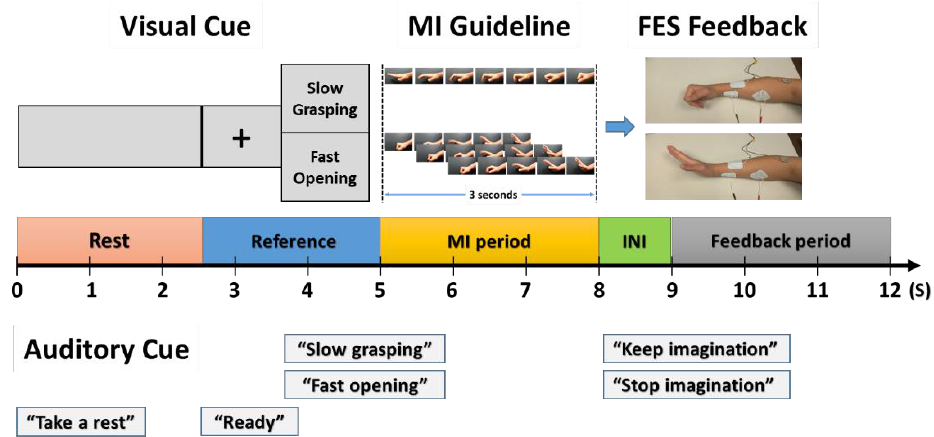
Figure 1. Schematic illustration of the experiment procedure. Text in the blue box indicates the auditory cue that played at the beginning of each period, and INI is an abbreviation of the Functional Electrical Stimulation (FES) initiation period. MI: Motor Imagery.